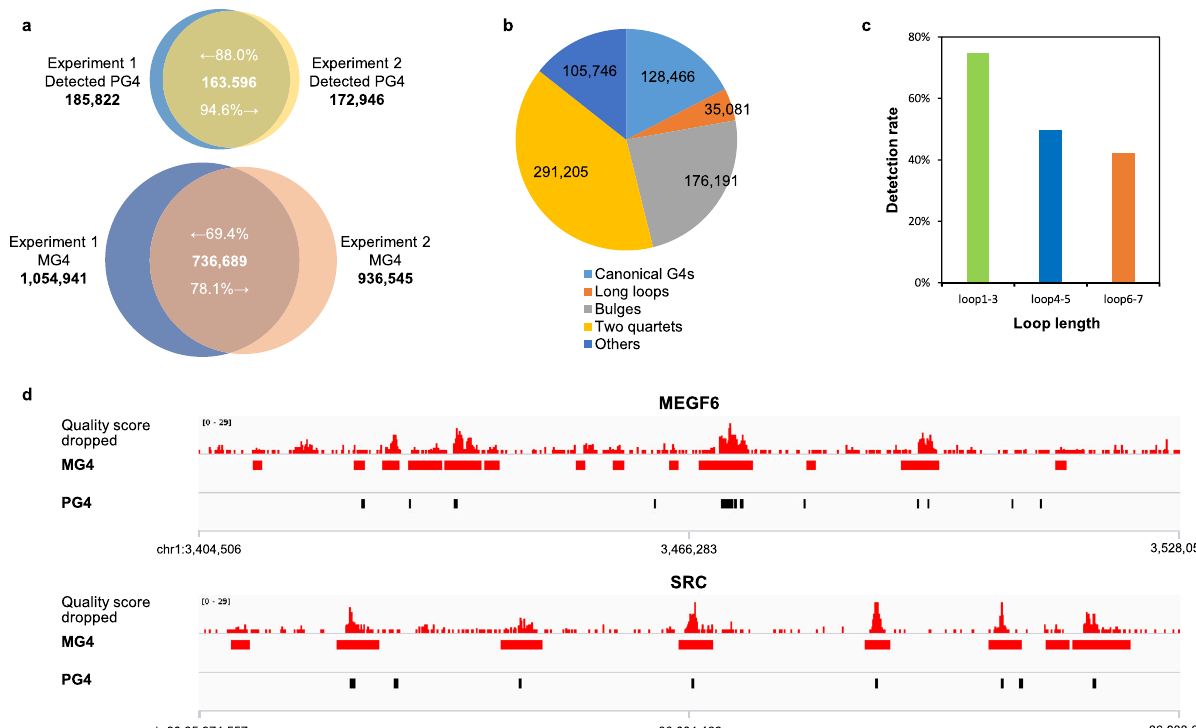
Fig. 3 Analysis of mined PG4s. a Overlap between PG4s that were detected in MG4s in two parallel runs and overlap between MG4s in two parallel runs. b Prevalence of MG4s by different G4 structural families. c Detection rate of canonical G4 sequences categorized by loop length. d Genome browser view of MG4 and PG4 across two oncogenes, MEGF6 and SRC. The median sequencing quality score dropped in each locus was tracked along the whole gene sequence. The regions above the threshold are shown as red bars (MG4s). The PG4s are shown as black bars. Table 1 Distribution of MG4s in different genomic regions. Region